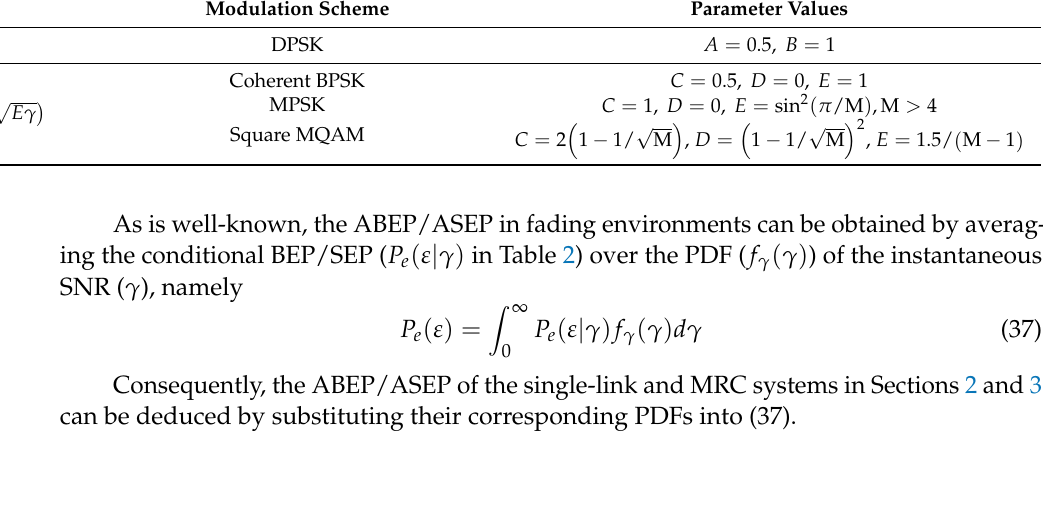
Table 2. Theoretical conditional BEP/SEP for several classical modulation schemes. BEP/SEP ( P e ( ε | γ ) ) Modulation Scheme Parameter Values